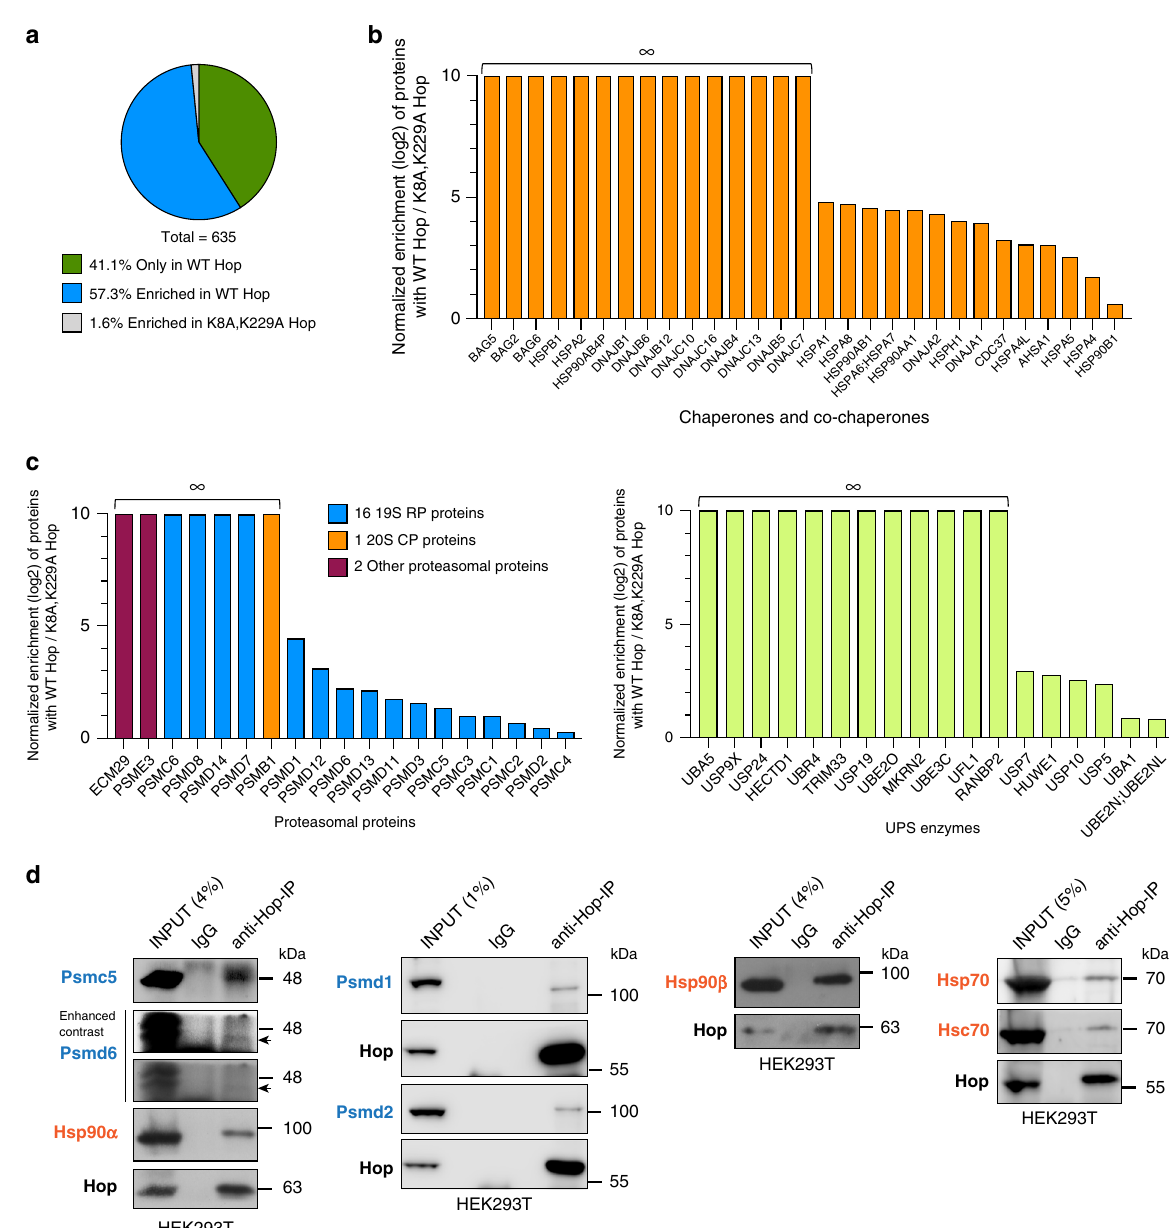
Fig. 3 Hop is associated with proteasomal proteins. a The pie chart represents the indicated groups of direct or indirect Hop interactors identi fi ed by IP- MS analysis of HA-tagged WT Hop and its TPR double mutant exogenously overexpressed in KO1 cells. b Bar graph with normalized log2 fold changes of Hsp70-Hsp90-related chaperone and co-chaperone proteins immunoprecipitating with the HA-tagged WT Hop compared to its TPR double mutant from KO1 cells by MS analysis as demonstrated in Supplementary Fig. 3b. ∞ , only identi fi ed with WT Hop ( n = 2 biologically independent samples). c Bar graphs as in panel b highlighting proteasomal proteins (left) and UPS-related enzymes (right). ∞ , only identi fi ed with WT Hop ( n = 2 biologically independent samples). d Validation of indicated proteasomal (in blue) and molecular chaperone (in orange) interactors of Hop in WT HEK293T cells by Hop-co-IP experiments. Normal IgG served as a negative control. For the Psmd6 immunoblot, the arrow indicates the band of the correct molecular weight. Validation of Hop interactors was performed with at least n = 2 biologically independent samples except for Psmd1 and Psmd2 ( n = 1). For bar graphs, the data are represented as mean values. Source data are provided as a Source Data fi le and Supplementary data fi (Supplementary Fig. 6h, i). Thus, the Hsp70-Hop-Hsp90 complex is essential for ef fi cient proteasomal capping and/or for optimal proteasomal stability/maintenance (Fig. 5h).